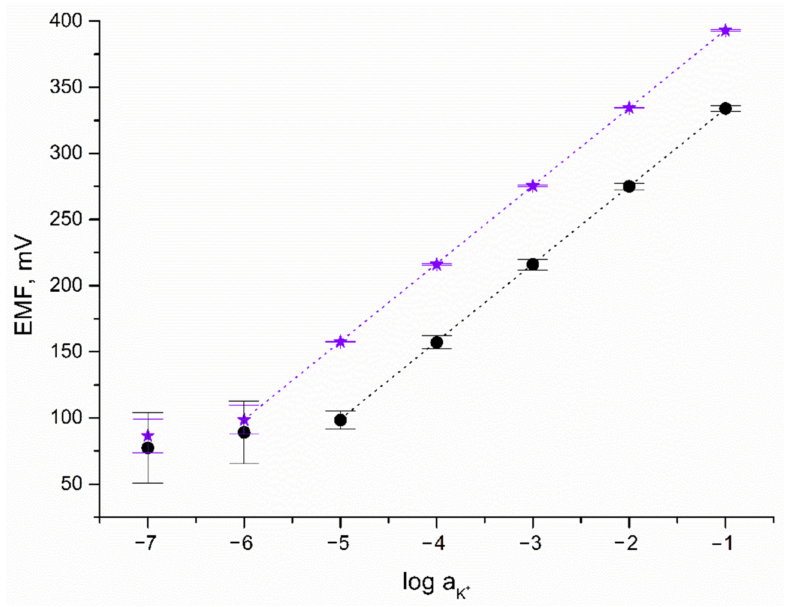
Figure 4. Potentiometric response of GC/IrO 2 · 2H 2 O/K + -ISM ( (cid:70) ) and GC/K + -ISM electrode ( • ) to- wards K +